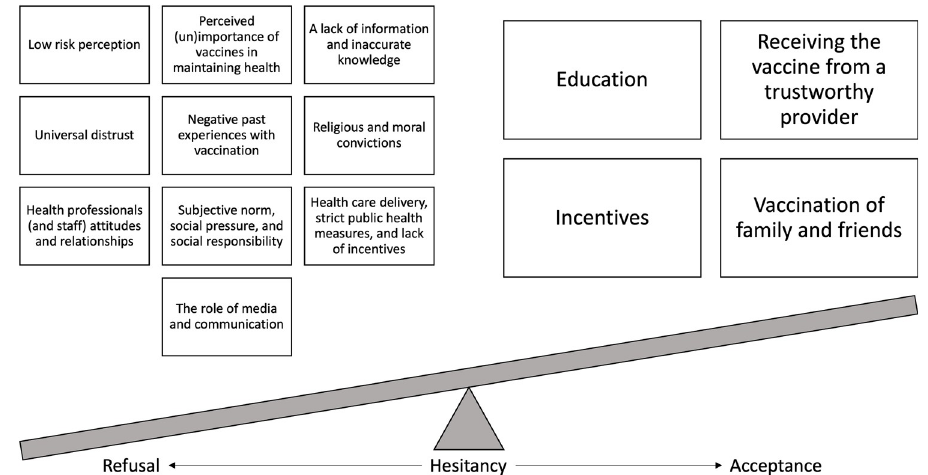
Fig 1. Reasons for COVID-19 vaccine refusal in Canadian federal prison settings and variables that could lead to